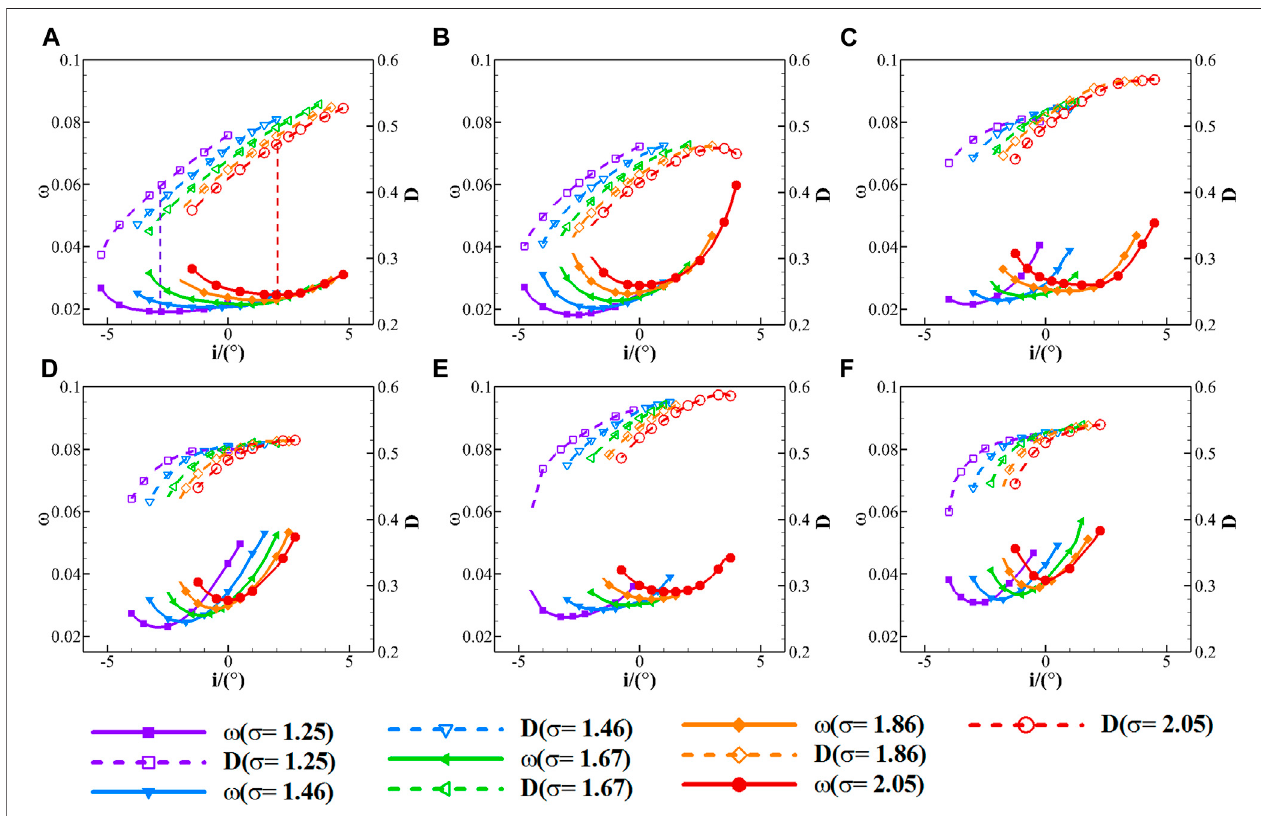
FIGURE7| In fl uenceofsoliditiesonincidencecharacteristicsoftotalpressurelosscoef fi cientanddiffusionfactor (A) e/b (cid:1) 0.2, θ (cid:1) 40 ° ; (B) e/b (cid:1) 0.6, θ (cid:1) 40 ° ; (C) e/ b (cid:1) 0.2, θ (cid:1) 44 ° ; (D) e/b (cid:1) 0.6, θ (cid:1) 44 ° ; (E) e/b (cid:1) 0.2, θ (cid:1) 46 ° ; (F) e/b (cid:1) 0.6, θ (cid:1) 46 °